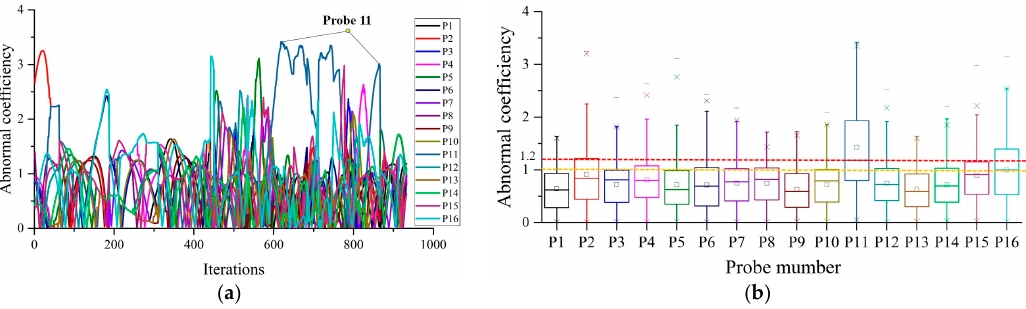
Figure 15. The abnormal coefficient and boxplot at the first 3 h of Vehicle 2. ( a ) The abnormal coefficient curves; ( b ) Boxplot of the abnormal coefficient.